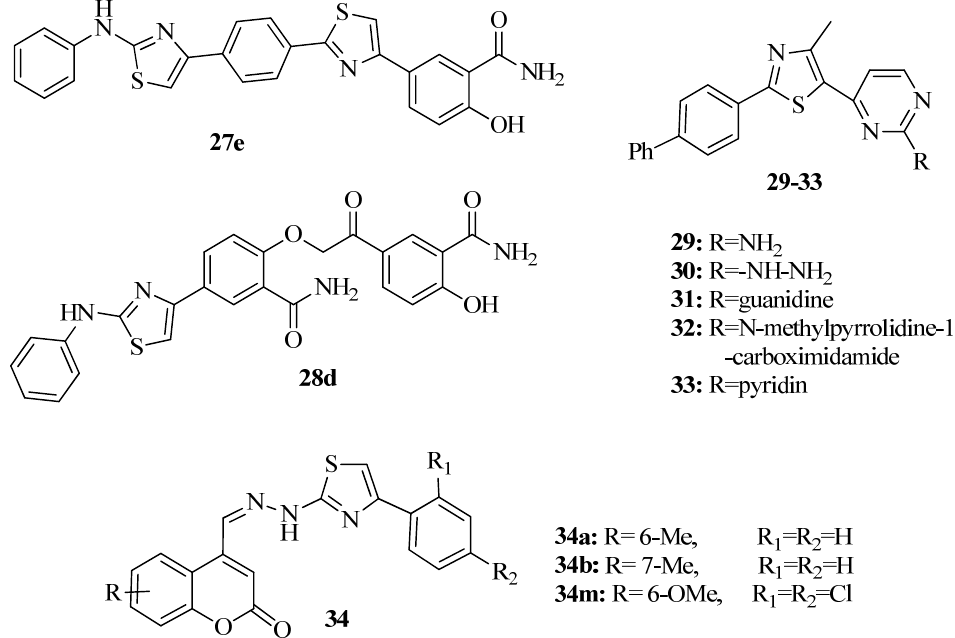
Figure 12. Structures of N -phenyl-4-(4-(thiazol-2-yl)-phenyl)-thiazol-2-amine derivatives (27,28), biphenylthiazole analogues, and chlorophenyl thiazolocoumarinyl hydrazides. Hagras et al. [62], based on their previous results [53], generated a new hybrid scaffold of 37 biphenylthiazole analogues ( 29 – 33 , Figure 12) with the aim to enhance both anti- MRSA activity and drug-like properties. Starting from the lead compound 29 with MIC 6.25 µ g/mL against MRSA, some modifications were performed. The structure–activity relationships revealed that the presence of a hydrophobic region around the pyrimidine position-2 is unfavorable. The introduction of a second amino group led to hydrazinyl compound 30 with an activity similar to vancomycin (MIC 1.25 µ g/mL). The incorporation of the terminal amine within the morpholine or piperazine moieties resulted in two very active cationic compounds, 31 and 32 (Figure 11) with MIC values of 3.12 and 0.78 µ g/mL, respectively. Thus, derivatives with a piperazinine side-chain exhibited a better activity than piperidine analogues. Moreover, aminopiperazine derivative 32 was found to be more potent than the corresponding derivative 33 without